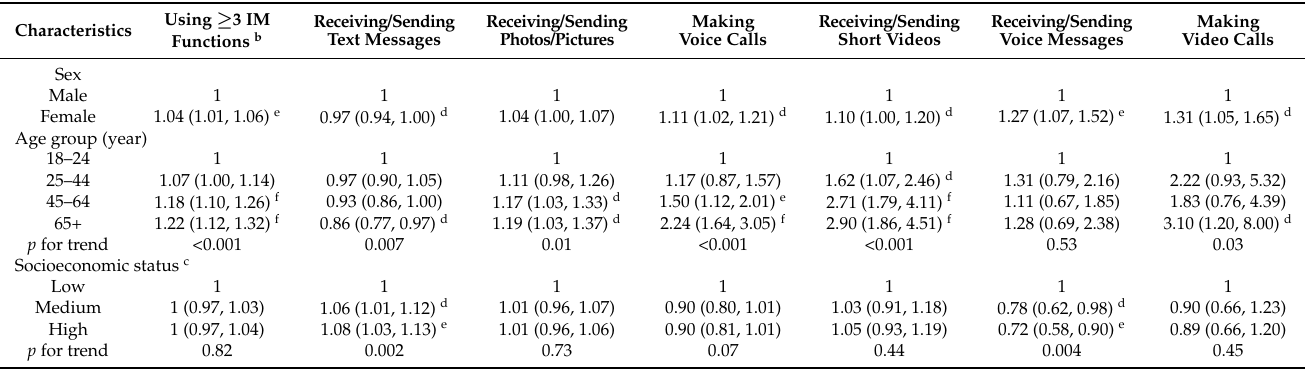
Table 3. Associations of sociodemographic characteristics with the number of IM functions and their use in family e-chat groups ( n = 4046), aPR (95% CI) a